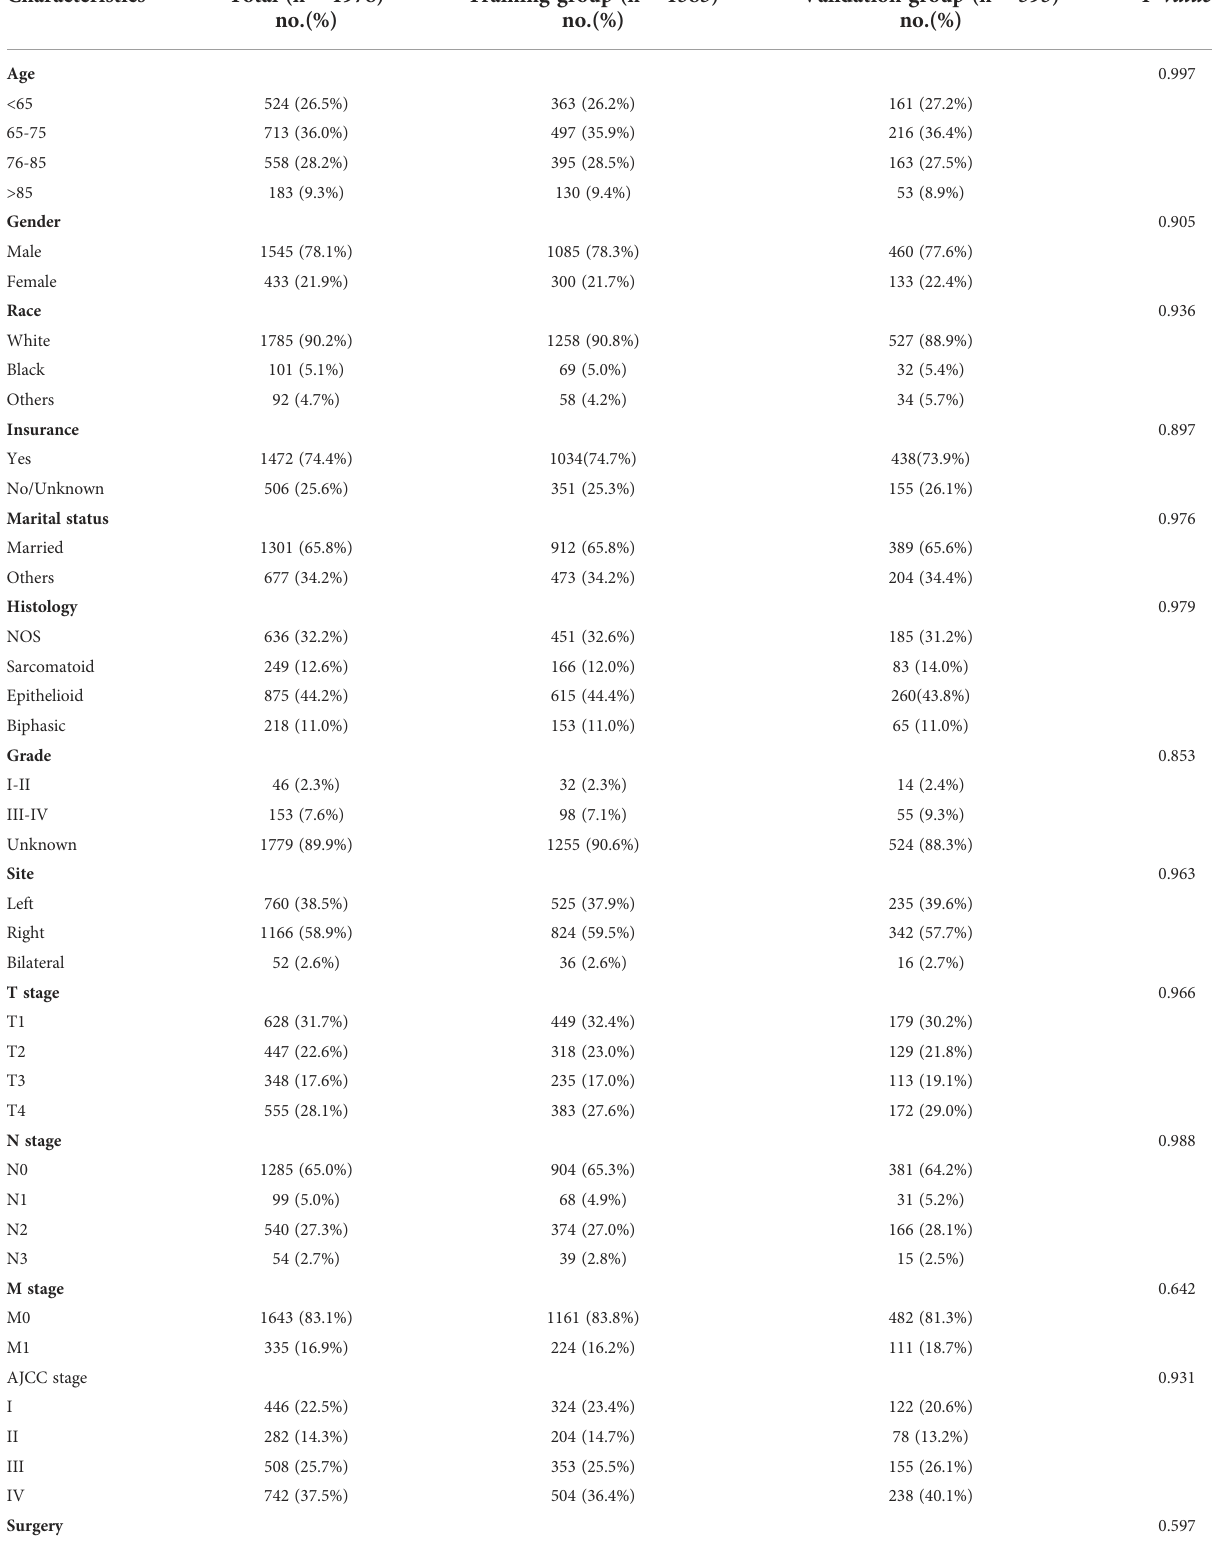
TABLE 1 Characteristics of patients with MPM in the training and validation